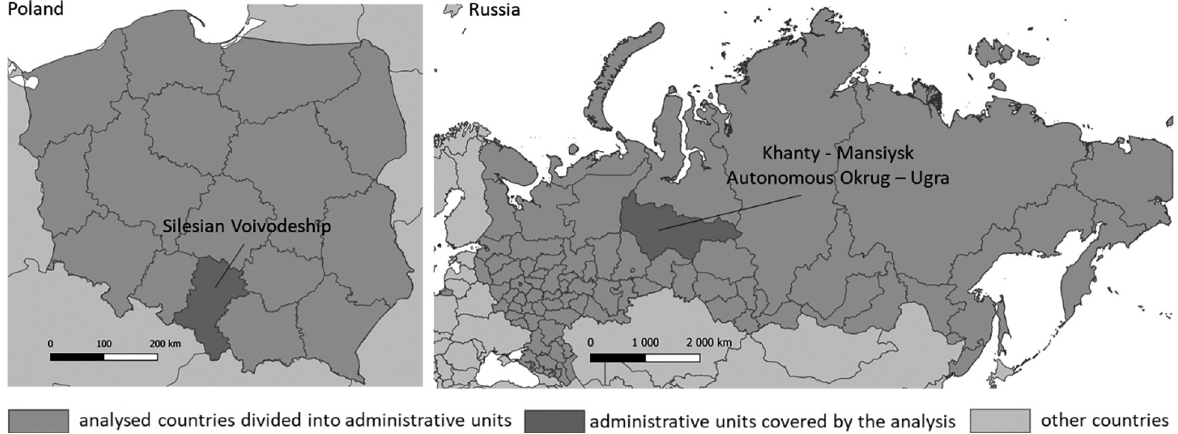
Fig. 1. Regions covered by the analysis in Poland (Silesian Voivodeship) and in Russia (KMAO – Ugra). KMAO – the Khanty-Mansiysk Autonomous Okrug. Source: own